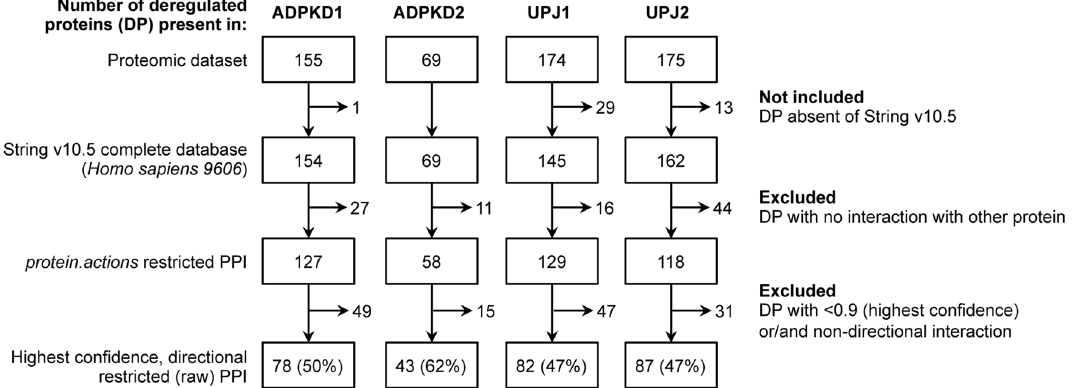
Figure 1. Number of deregulated urinary proteins from proteomic datasets present in the raw PPI network. Part of the deregulated proteins (DP) present in the proteomics datasets could not be included as they were absent in String v10.5 database (Homo sapiens). Moreover, a number of DP was excluded as they did not share any interaction with other proteins (absent from protein.actions PPI) or did not have a directional interaction with highest confidence (> = 0.9). PPI: protein–protein interaction network; DP: deregulated protein.